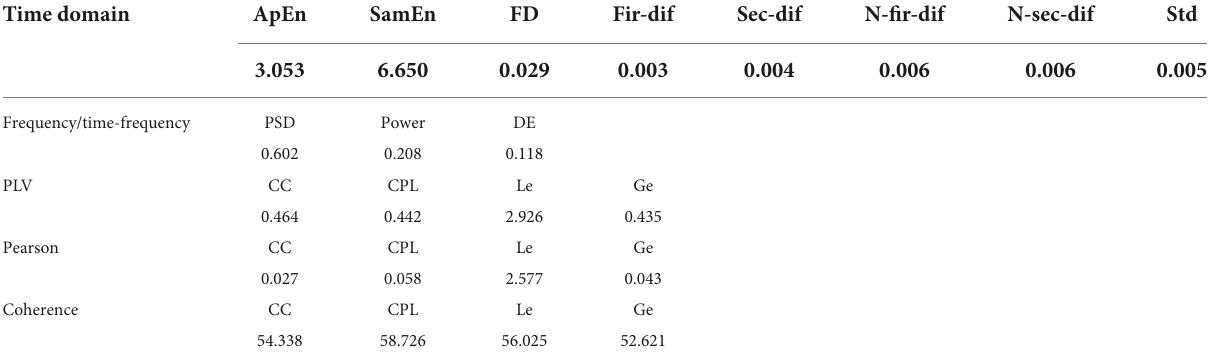
TABLE 2 Calculation time of different features